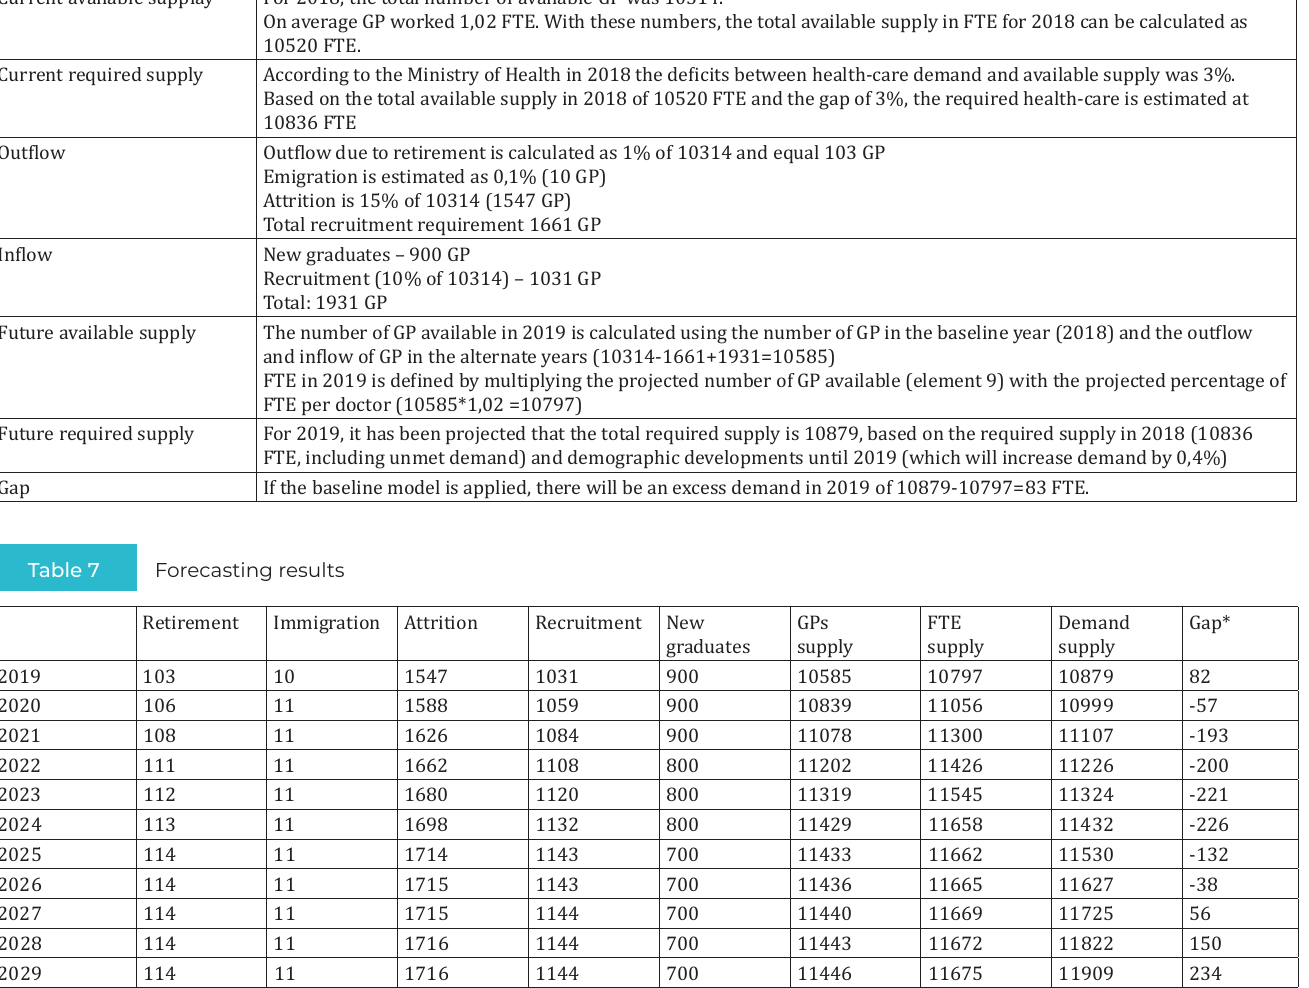
Current available